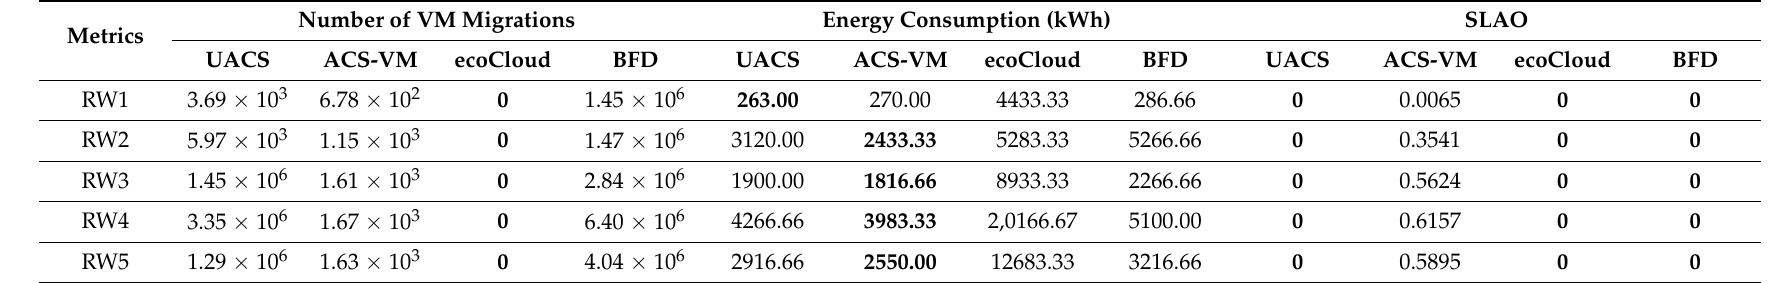
The results with boldface are the best results among the compared algorithms. Table 3. The number of VM migrations, energy consumption, and the SLAO violated levels of UACS, ACS-VM, ecoCloud, and BFD on real workloads, RW6, RW7, and RW8.